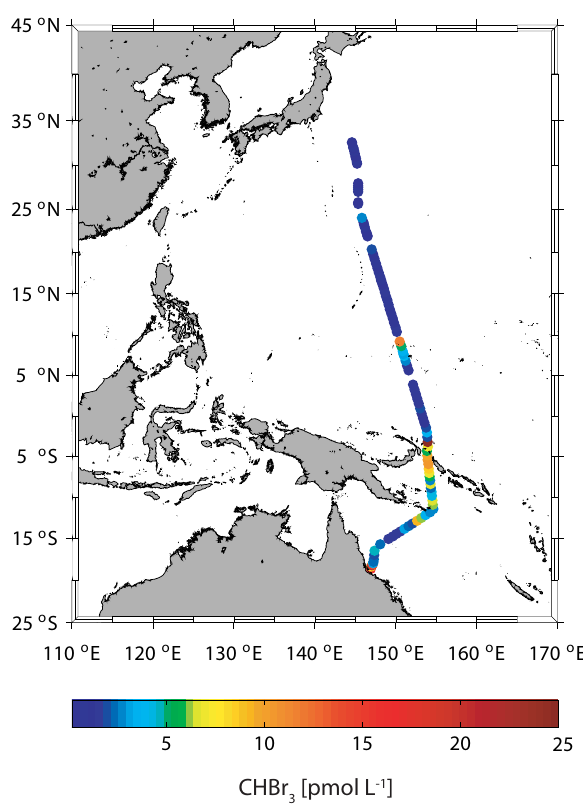
Fig. 6. Oceanic bromoform concentrations (pmol L − 1 ) along the TransBrom Sonne cruise track during October 2009; measurement intervals are